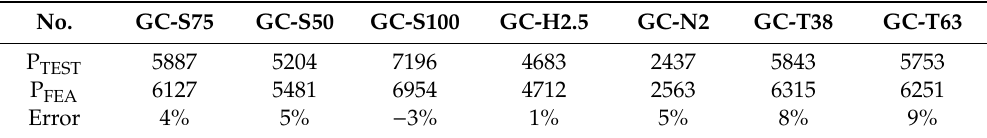
Table 5. Comparison of peak